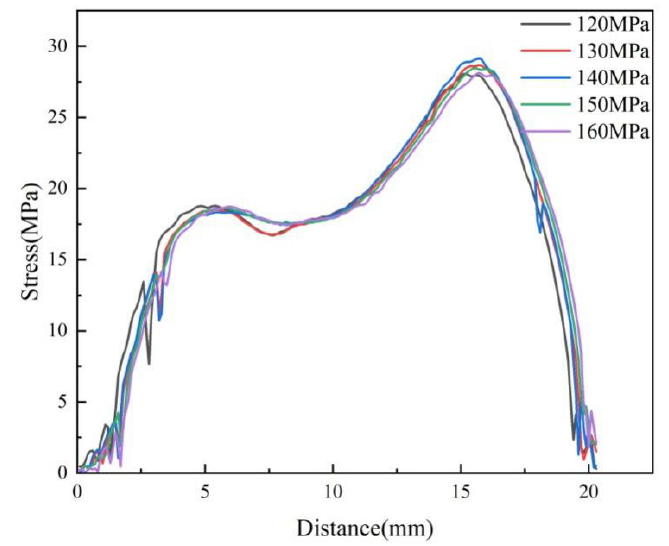
Figure 12. Variations of stress curve at different packing pressures along the centerline of the parts.